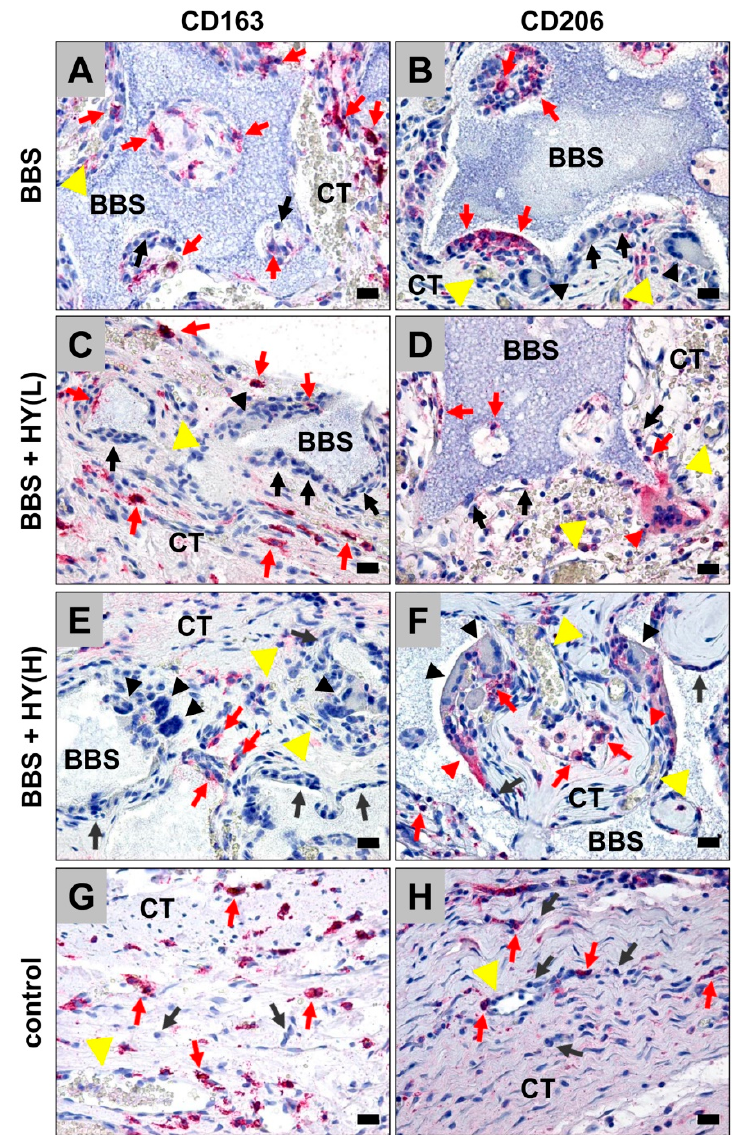
Figure 2. Exemplary histological images from the implantation beds of the analyzed pure biphasic bone substitute (BBS) ( A , B ) and the groups of the BBS combined with low (BBS + HY(L), ( C , D )) and high (BBS + HY(H), ( E , F )) concentrations of high molecular weight hyaluronan (HMWHY) embedded in connective tissue (CT) and the control group ( G , H ). CD163- and CD206-positive macrophages (red arrows), negative macrophages (black arrows), and CD163- and CD206-positive (red arrowheads) and -negative (black arrowheads) biomaterial-induced multinucleated giant cells (BMGCs) (vessels = yellow arrows) (CD163- and CD206- immunostainings, 200 × magnifications, scale bars = 20 µm).